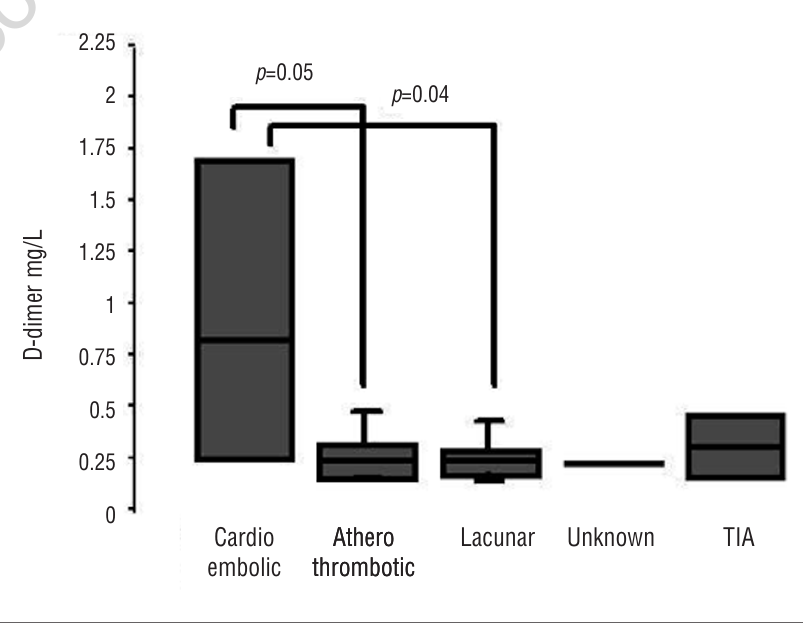
Figure 1. D-dimer levels in relation to stroke